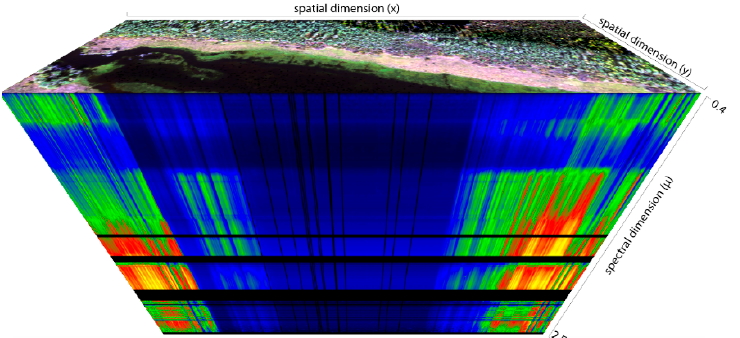
Figure 3. Example of a HySpex hypercube for the flight area C. A flight line hypercube with spatial dimensions, x and y, and spectral dimension, µ . Each spatial pixel in the flight line has a corresponding spectral signal from 0.4 to 2.5 µ m. Dark horizontal regions in the spectral dimension were masked out due to water absorption bands.